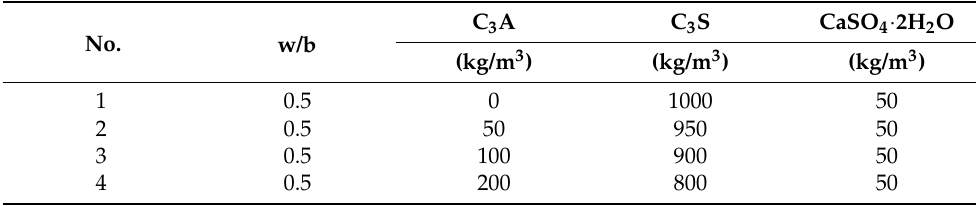
Table 1. Mixture proportion of C 3 A-C 3 S paste.